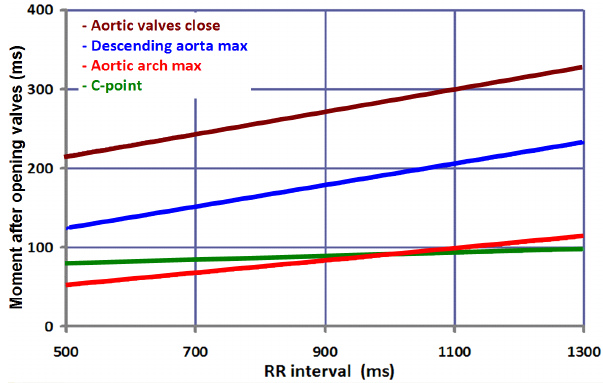
Figure 5: Typical example of the relationships of the time interval between the start of the ejection phase (opening aortic valves) and the heart cycle markers. Data from the same subject as in Figure 4 were used.